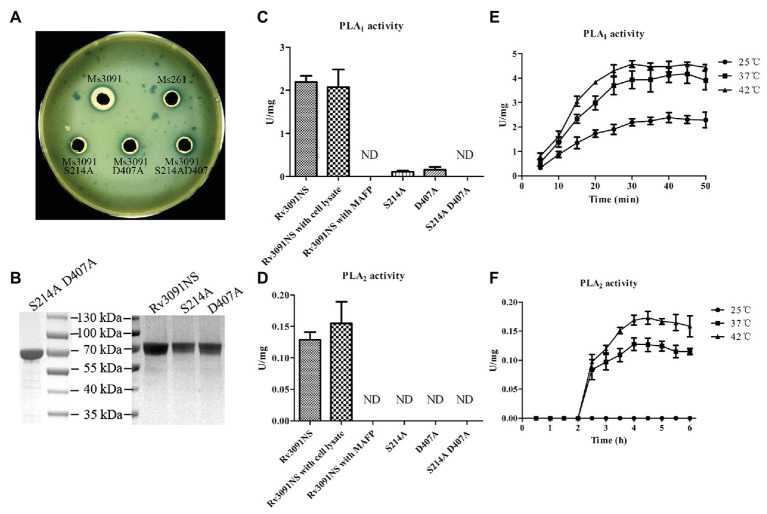
Evaluation of phospholipase activity of recombinant proteins. (A) The phospholipase activity of recombinant M. smegmatis (rMs) cell lysate supernatants on yolk agar plates. Ms3091, Ms3091S214A, Ms3091D407A, Ms3091S214AD407A, and Ms261 were spotted onto yolk agar plates for 24 h at 37°C. The creamy white zone in each halo represents the activity of phospholipase. (B) Sodium dodecyl sulfate polyacrylamide gel electrophoresis (SDS-PAGE) analysis of purified recombinant Rv3091NS, S214A, D407A, and S214AD407A proteins. (C) The PLA1 activities were measured at 25°C for 30 min. (D) The PLA2 activities were measured at 37°C for 4 h. (E) PLA1 activities were measured at 25, 37, and 42°C. (F) PLA2 activities were measured at 25, 37, and 42°C. ND, not detectable.